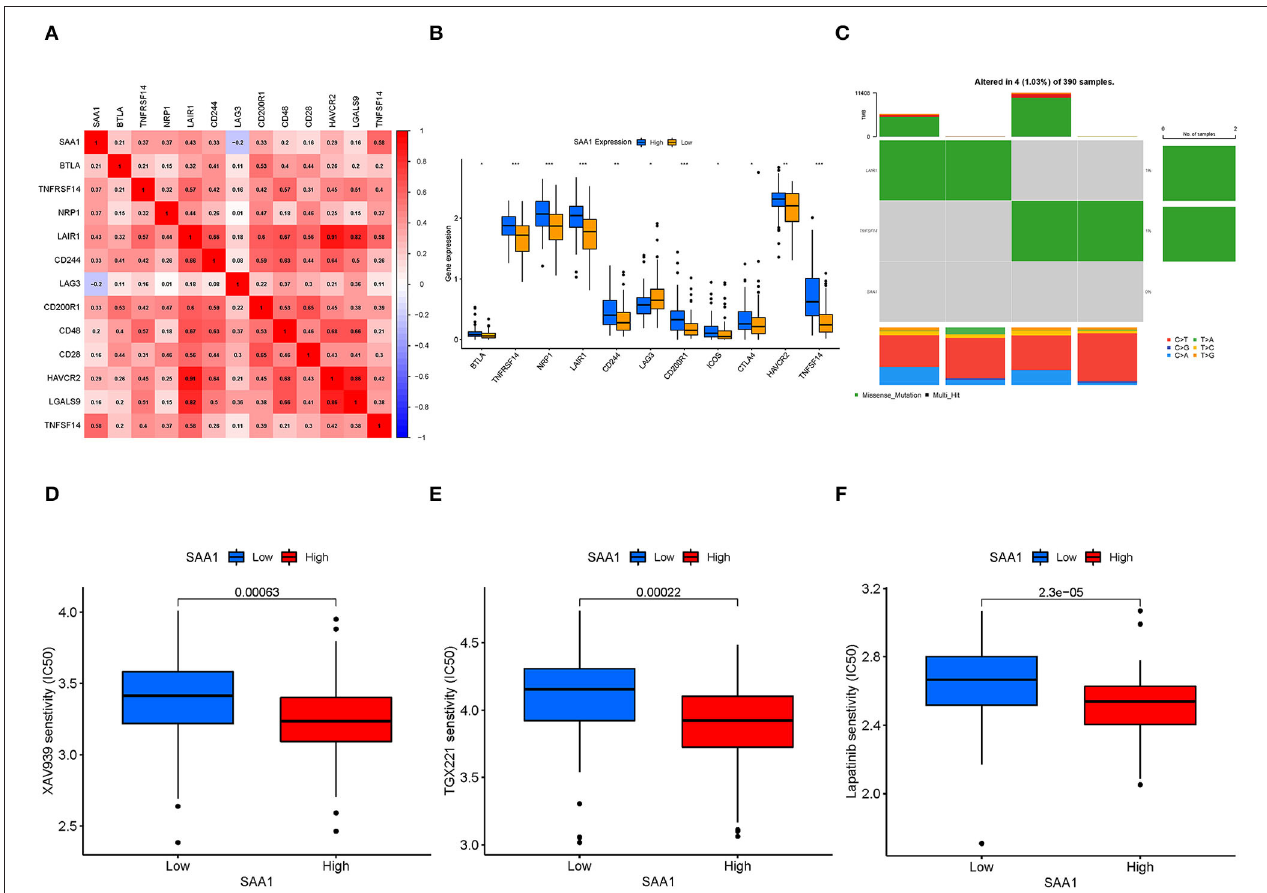
FIGURE 11 | Immune checkpoint genes, TMB, and drug sensitivity. (A) Heatmap shows the correlation between SAA1 and immune checkpoint genes, and the numerical value in each box indicates Pearson’s correlation coefficient between the two genes. (B) Box plot of differentially expressed immune checkpoint genes between SAA1 high- and low-expression groups. (C) Heatmap of TMB for SAA1, LAIR1, and TNFSF14 in GBM. (D–F) Drug sensitivity of XAV939, TGX221, and lapatinib showed lower IC50 in the SAA1 high-expression GBM group, p <